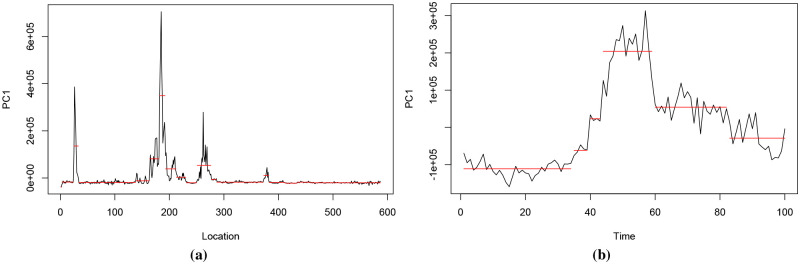
Change points of the first PC scores of the dataset in Fig 4.Fig 9a shows the first PC scores when taking each location as an observation. The horizontal red lines denote the levels and the change points correspond to the breaks or discontinuities of levels. Fig 9b shows the first PC scores when taking each time point as an observation and the associated change points.